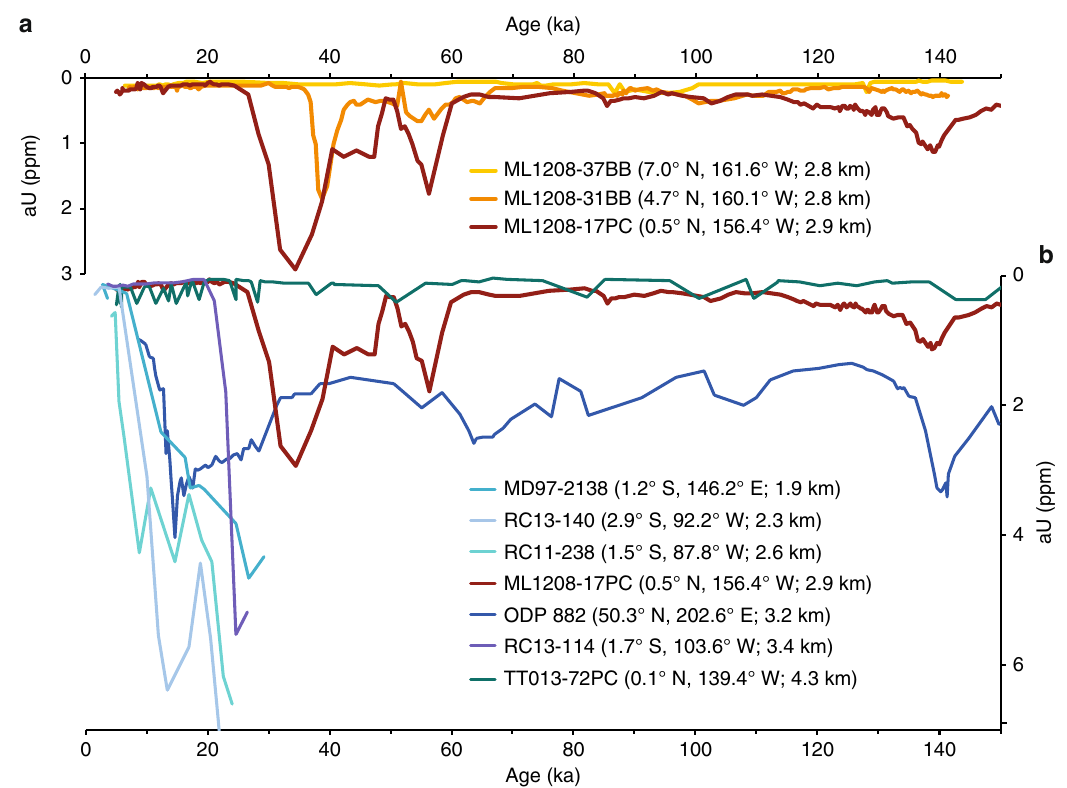
Fig. 2 Records of aU from the Paci fi c Ocean. Sedimentary aU records from ML1208 sediment cores 17PC (dark red), 31BB (orange) and 37BB (gold). a . Comparison of aU records from the Paci fi c Ocean including 17PC (this study), ODP Site 882 12 , TT013-72PC 37, 38 , MD97-2138 13 , RC11-238 13 and RC13-140 13 with colours and locations as depicted in